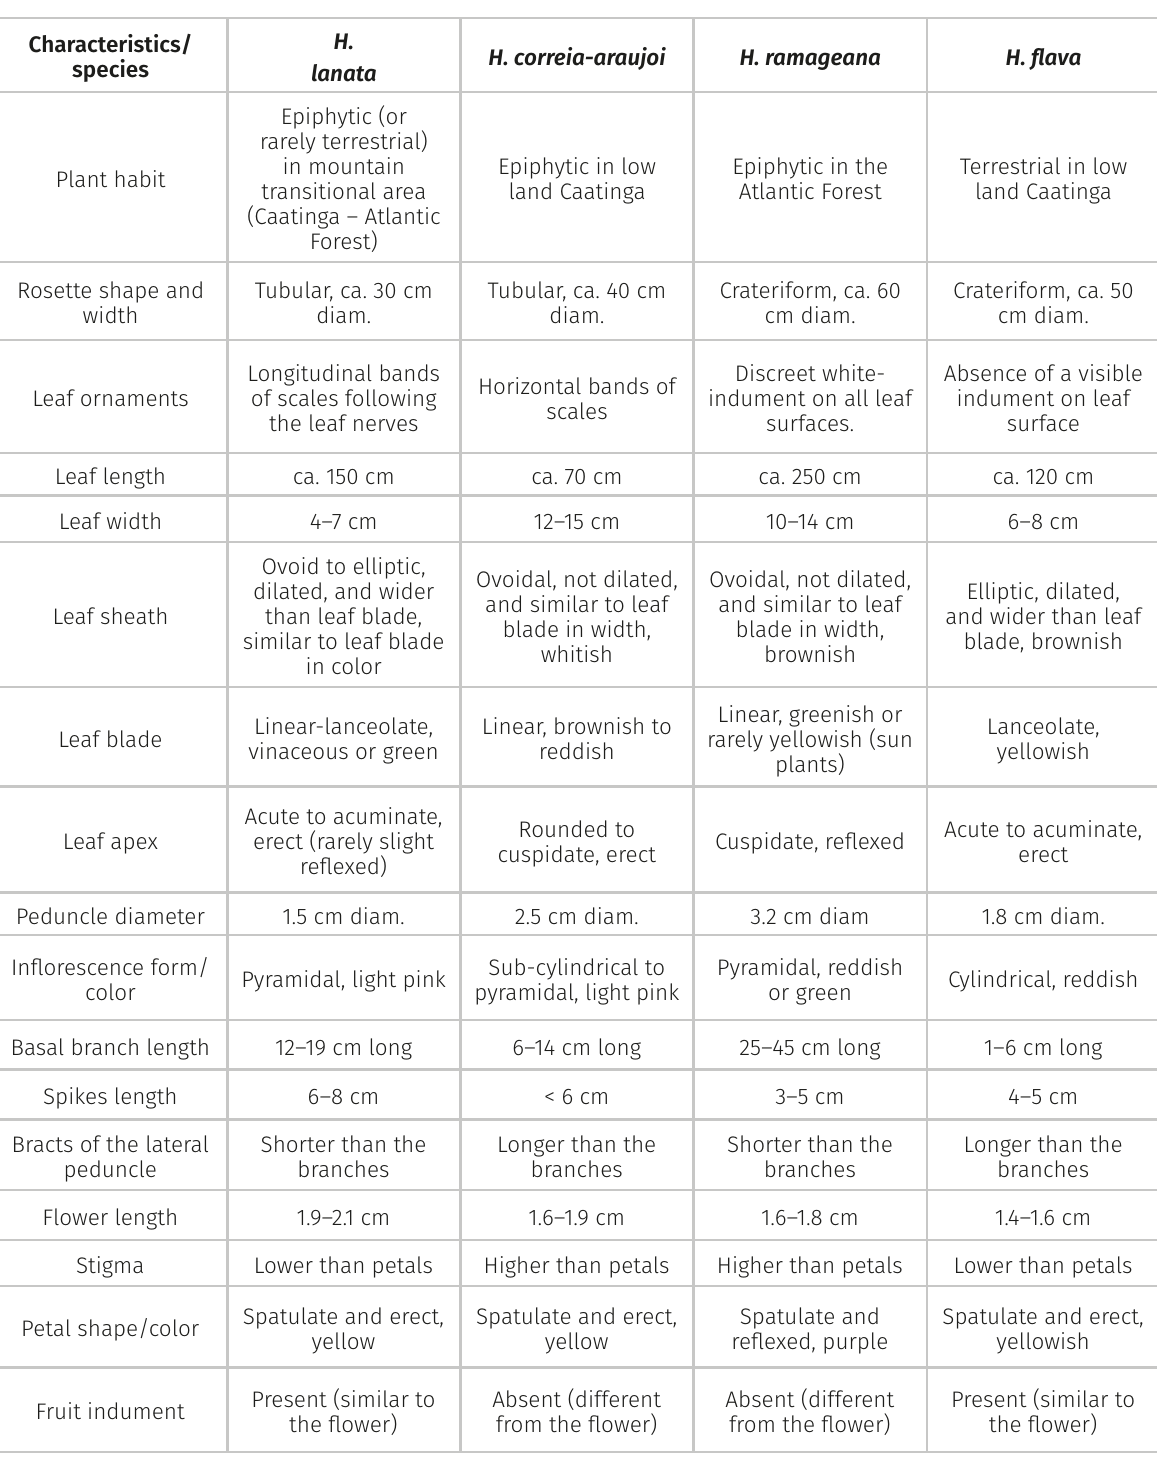
Table I. Morphological comparisons between Hohenbergia lanata , Hohenbergia correia-araujoi, H. ramageana, and H. flava. The measurements are based on the original description of each species and were complemented by observations of living